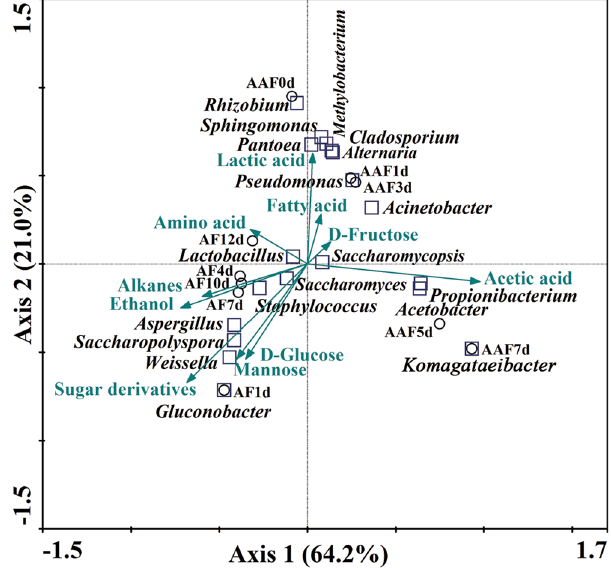
Figure 5. Canonical correspondence analysis of dominant microorganisms, fermentation time, and primary metabolites in SAV. Arrows represent different metabolites. Blocks represent dominant microorganisms. Circles represent different fermentation time. AF1d –AF12d represent 1 day to 12 days of alcohol fermentation, and AAF0d–AAF7d represent 0 day to 7 days of acetic acid fermentation. Axes 1 and 2 can explain 85.2% of the data